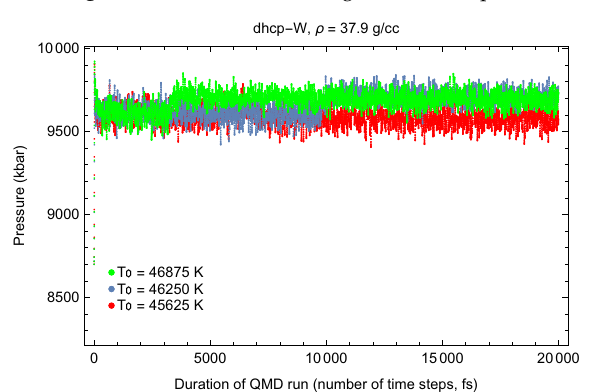
Figure 12. The same as in Figure 2 for